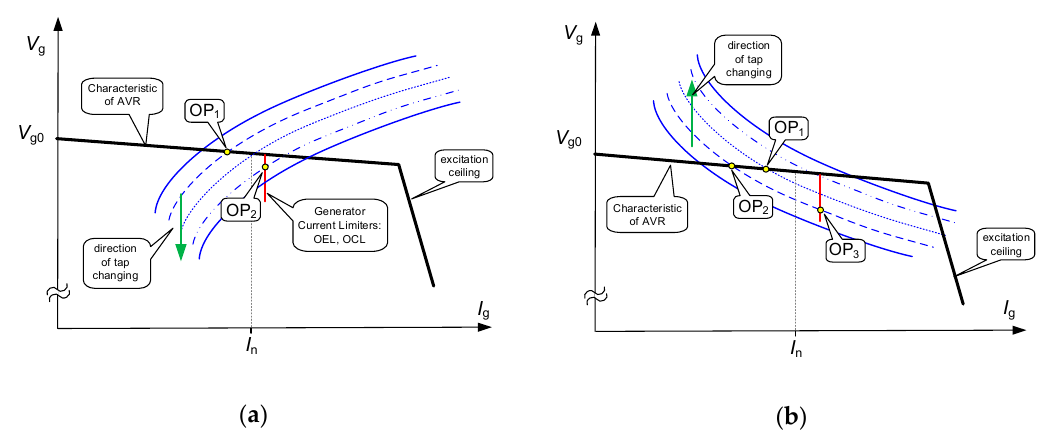
Figure 7. Impact of the transformer tap-ratio control on the risk of voltage collapse: ( a ) positive effect of blocking transformer ratio changes; ( b ) unfavorable effect of blocking transformer ratio changes.